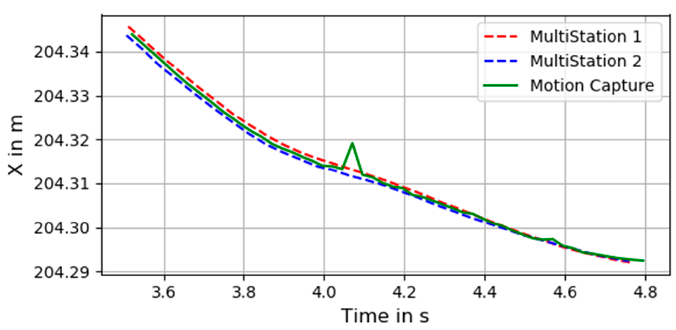
Figure 9. Measurements of circular rotation.